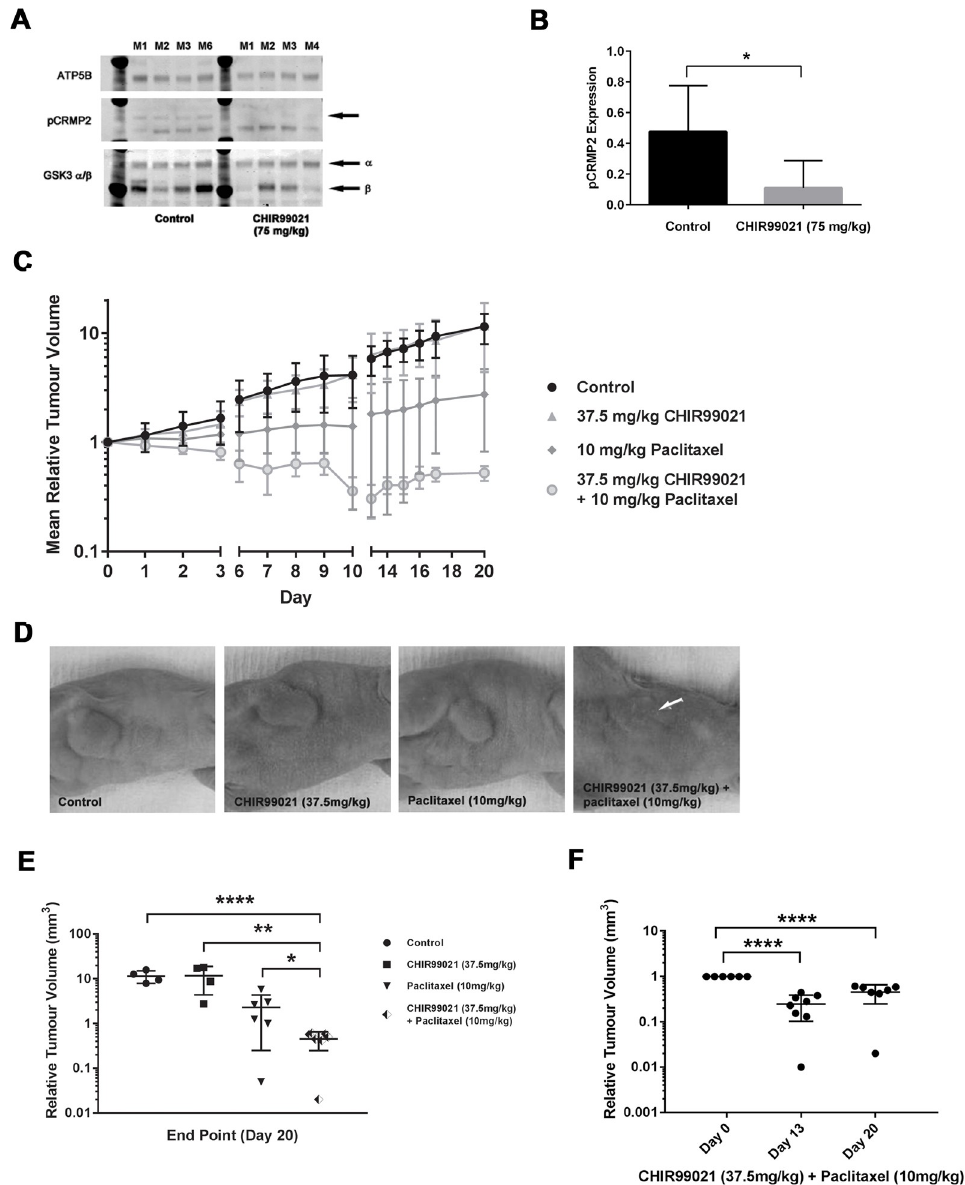
Fig 4. Combined treatment with CHIR99021 and paclitaxel suppresses H1975 tumor growth in vivo . In Panel A , in vivo inhibition of GSK3 activity by CHIR99021 was confirmed by western blot analysis of the phosphorylation status of the GSK3 substrate, CRMP2, in a panel of representative H1975 tumor tissues analysed at day 20 (Panel A) . The arrow in the pCRMP2 blot indicates the pCRMP2 band. Panel B , provides ImageJ quantification of the western blots and reveals a significant decrease ( p < 0.05) in CRMP2 phosphorylation in CHIR99021 (75 mg/kg) vs . control (levels were normalized to the ATP5B loading control). In Panel C , H1975 tumors were implanted in the right hind limb of Balb/C athymic nude mice and administered with or without a single intraperitoneal half-maximally tolerated dose of paclitaxel, with or without an additional half-maximally tolerated oral dose of CHIR99021 twice daily every five days for three weeks, with a two day treatment holiday between each five day regimen (n = 8 mice per treatment group). Reduction in tumor volume was observed for the mice treated with 10 mg/kg paclitaxel; however, no effect was noted in the 37.5 mg/ kg CHIR99021 cohort. Strikingly, the combination of 37.5 mg/kg CHIR99021 with 10 mg/kg paclitaxel substantially attenuated tumor growth. In Panel D , representative images of end-point tumors taken from mice in each cohort. The white arrow indicates the location of each tumor, which fully recedes following treatment with the two drugs in combination. Panel E , provides the median tumor size which was analysed at the study end-point (n = 4–7 per group) with p values of p < 0.0001 ( ���� ), 0.002 ( �� ) and 0.04 ( � ) indicated. In Panel F , we compared the effect of treatments on tumor volume at day 13 and day 20 versus that at day 0 (mean ± standard deviation is shown; ���� indicates p < 0.0001). No significant difference was found between day 13 and day 20 tumor volume.